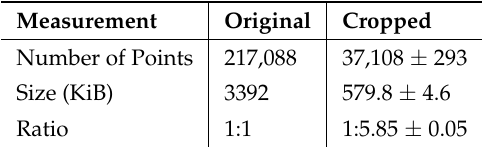
Table 2. Point cloud filtering and cropping results. Cropped results are mean values over 1000 measured point clouds.